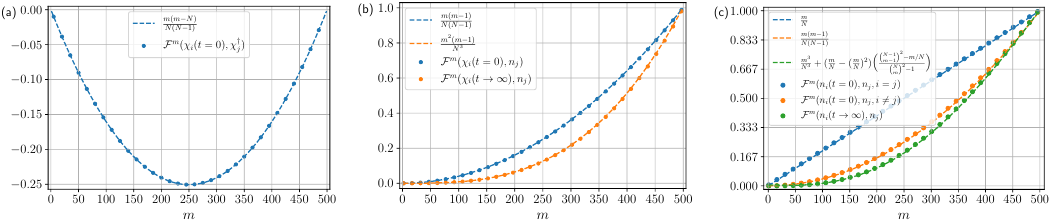
(a) Benchmarking of the initial values of the OTOC F m ( χ and different m . (b) Benchmarking of the initial and final values of the OTOCs F m ( χ for N = 500 and different m . (c) Benchmarking of the initial and final values of the OTOCs F m ( n i ( t ) , n j ) , for N = 500 and different m . All of the benchmarking has been performed using the numerical values obtained using the Lie Algebra method and the values obtained analytically listed in table